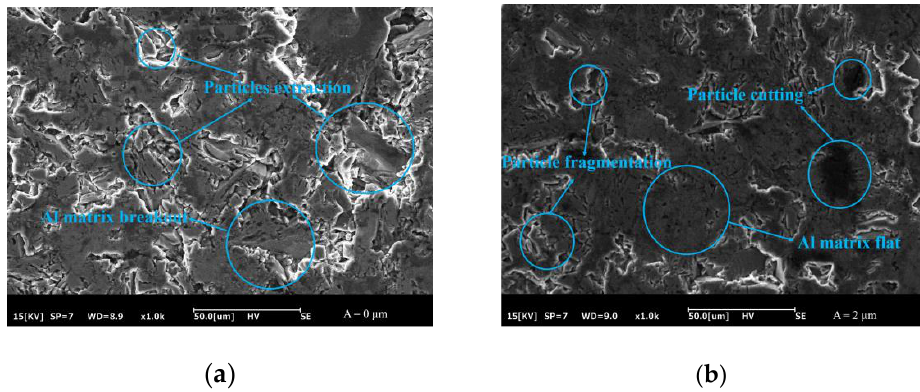
Figure 3. Surface micromorphologies of ordinary and ultrasonic vibration-assisted grinding. ( a ) Ordinary grinding and ( b ) ultrasonic vibration-assisted grinding.